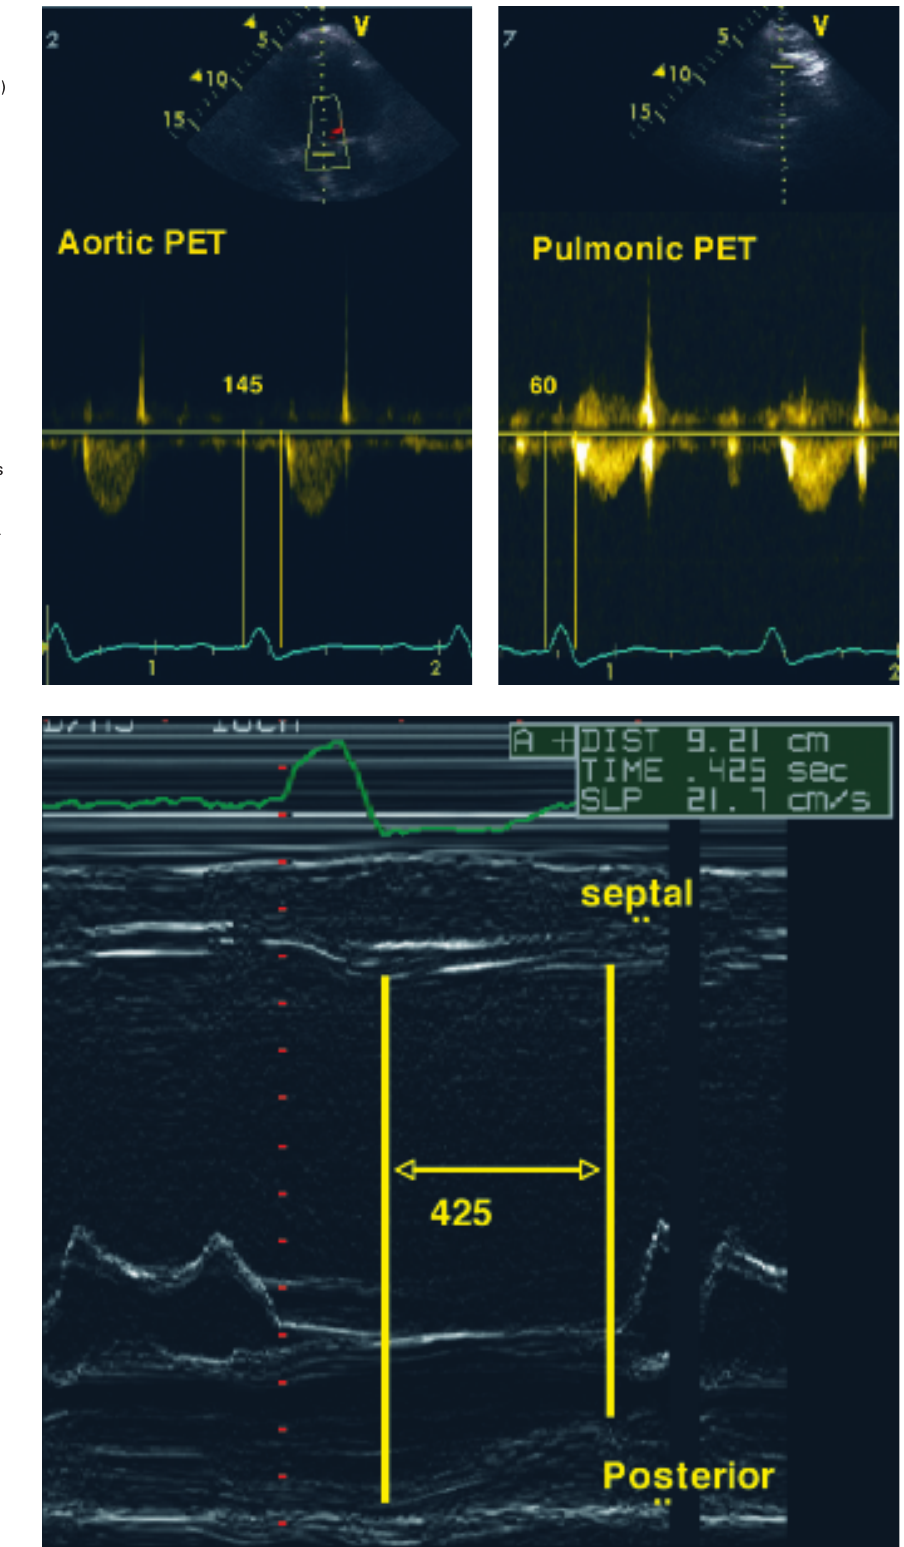
Assessment of the interventricular me- chanical delay (IVMD) by Doppler echocar- diography. The presystolic ejection time (PET) is calcu- lated by measuring the time from the onset of the QRS- complex and the beginning of the Doppler-ejection sig- nal across the aortic valve (APET) and the pulmonary valve (PPET), respectively. IVMD is then calcu- lated by substracting PPET from APET (here: IVDM = 145 ms – 60 ms = 85 ms; IVDM >40 ms indica- tive for interventricu- lar dyssynchrony).